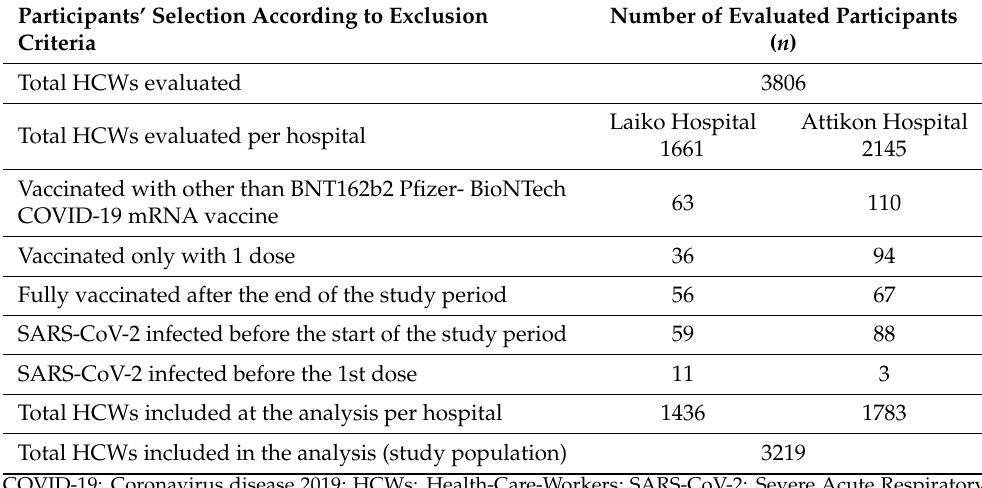
Table 1. Participants’ selection among Health-Care-Workers (HCWs) in two Academic Hospitals in Athens,